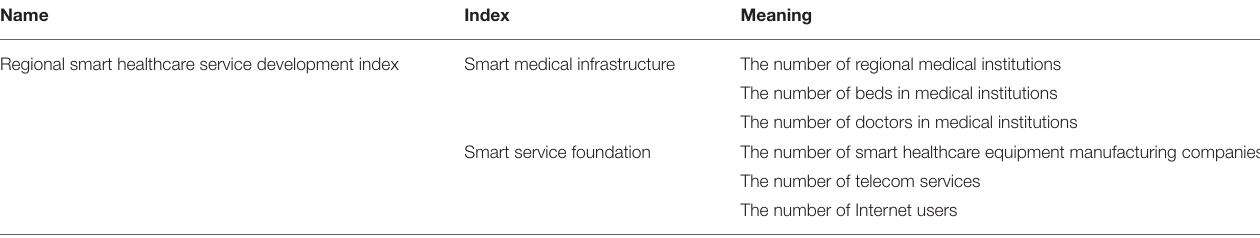
TABLE 2 | Variable definition and assignment.